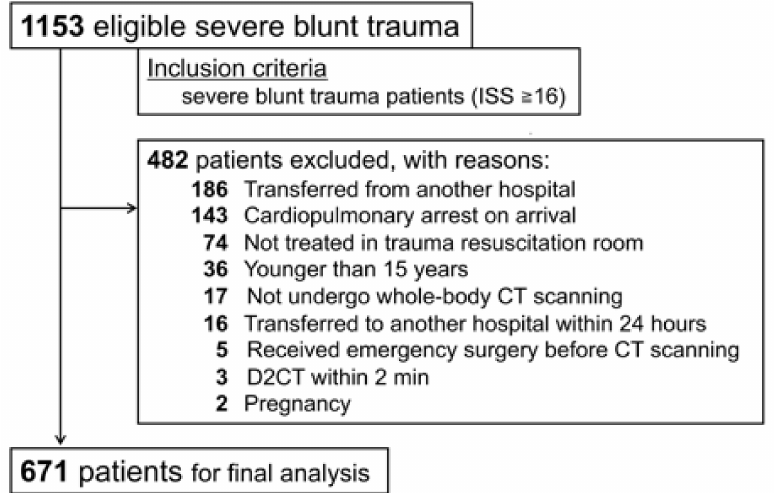
Figure 1. Patient flow diagram. ISS, Injury Severity Score; CT, computed tomography and D2CT, door-to-computed tomography